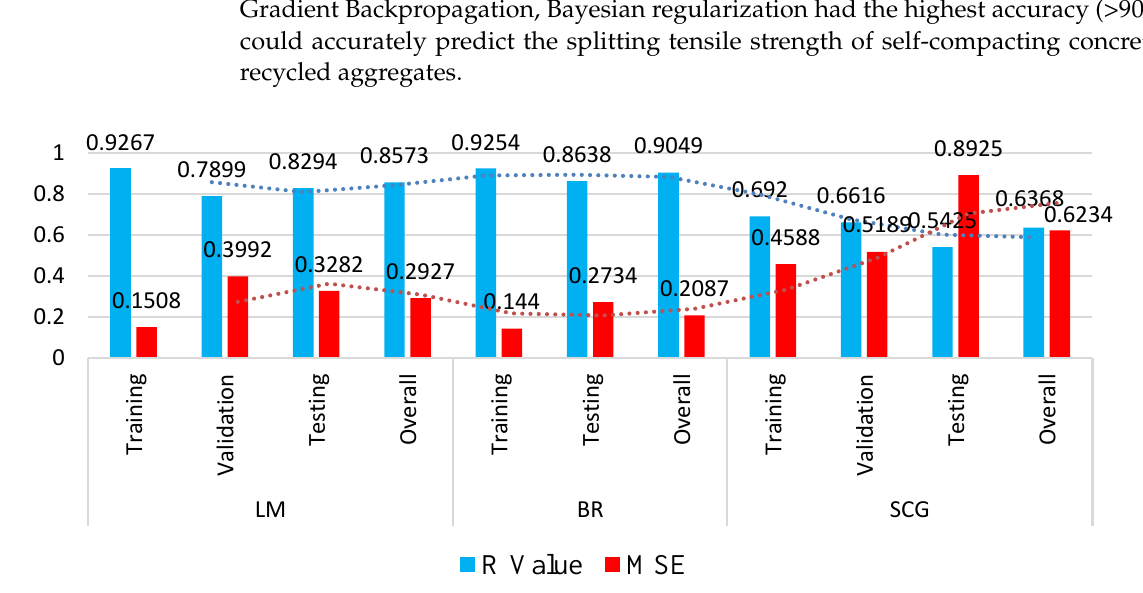
Figure 16. R-value and MSE of LM, BR, and SCGB algorithms.